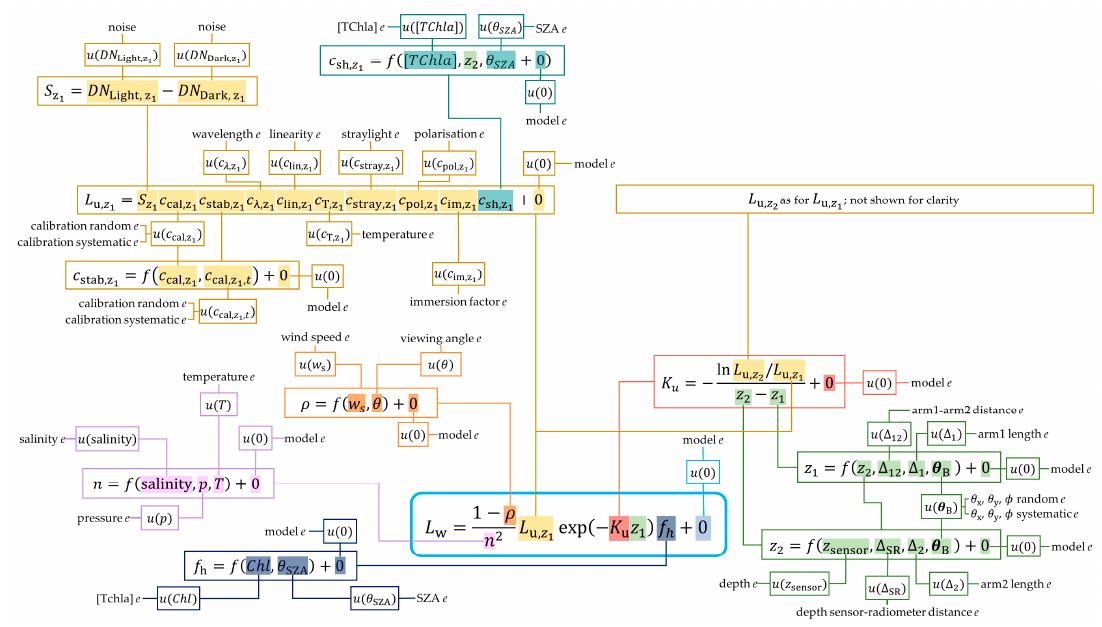
Figure 25. Water leaving radiance in situ measurement uncertainty tree diagram.